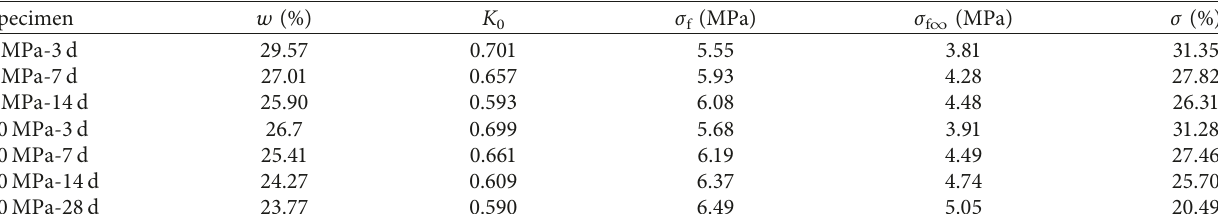
Table 5: Instantaneous and long-term strengths of the frozen